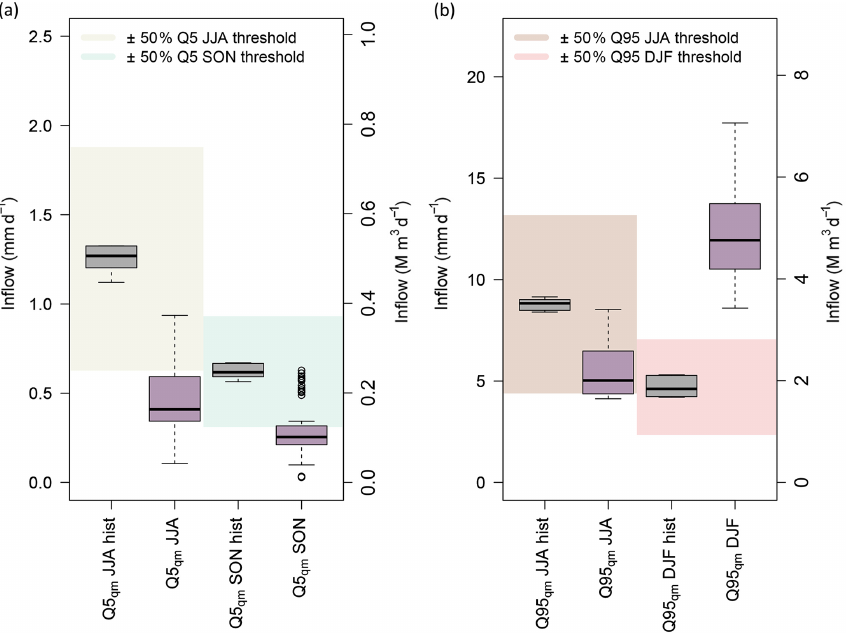
Figure 5. (a) Boxplots showing low-flow (Q5) and (b) high-flow (Q95) indices, where the historical period (gray boxplots; 1980–2009) is compared to the future period (purple boxes; 2070–2099) for inflows entering the Vernex reservoir. All projections shown are for RCP8.5. For each index, an associated ± 50% threshold is designated by the shaded area. These thresholds are based on the mean of simulations when forced by observed climate data ( Q ref ) over the period from 1980 to 2009.